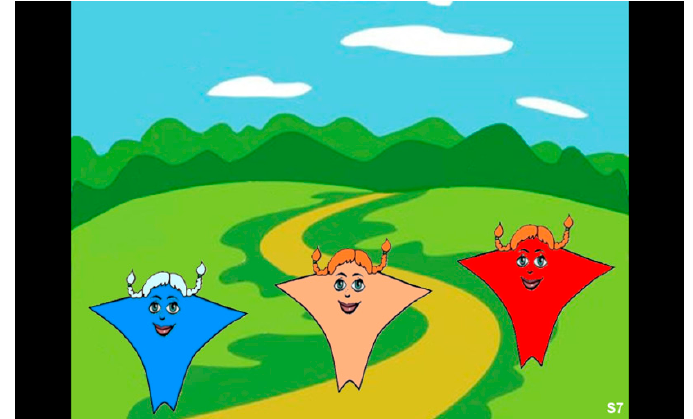
Figure 1. Example of animate female gendered characters. Aquí hay tres noletes ‘here there are three noletes’.